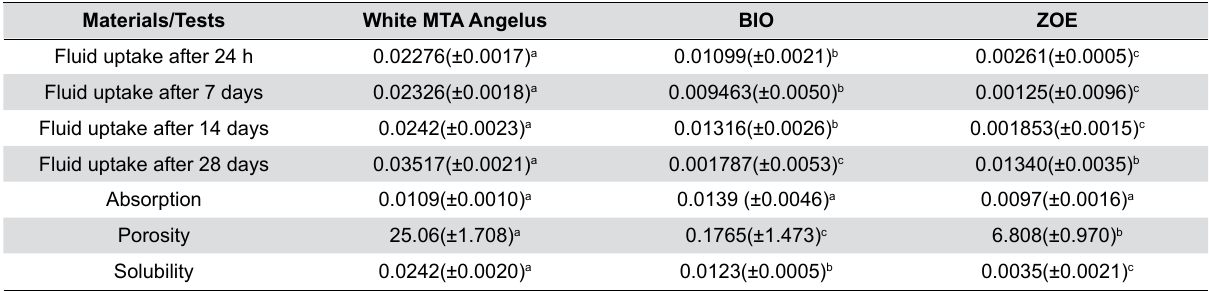
Table 3- Mean and standard deviation of the results of fluid uptake, absorption, porosity and solubility (%) after immersion in Hank’s balanced salt solution